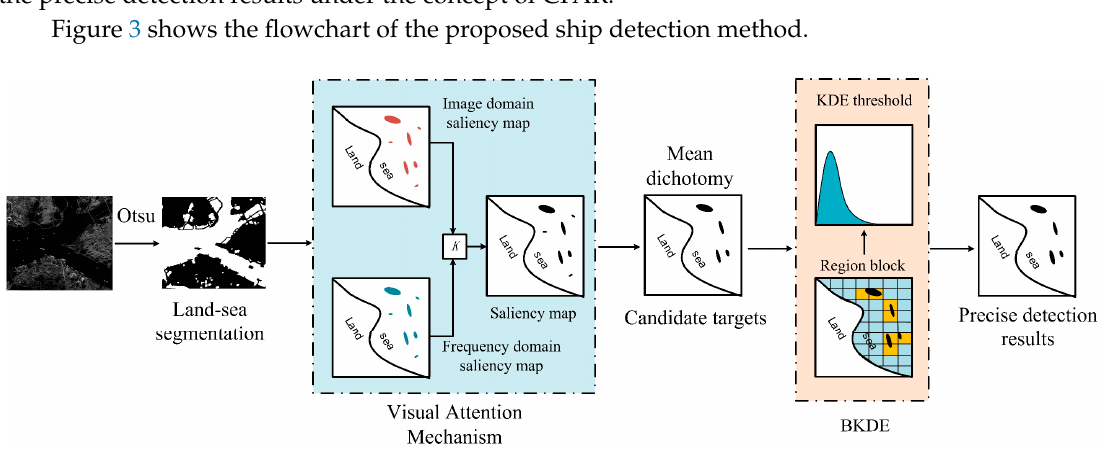
Figure 3. Pipeline of the proposed ship detection method.